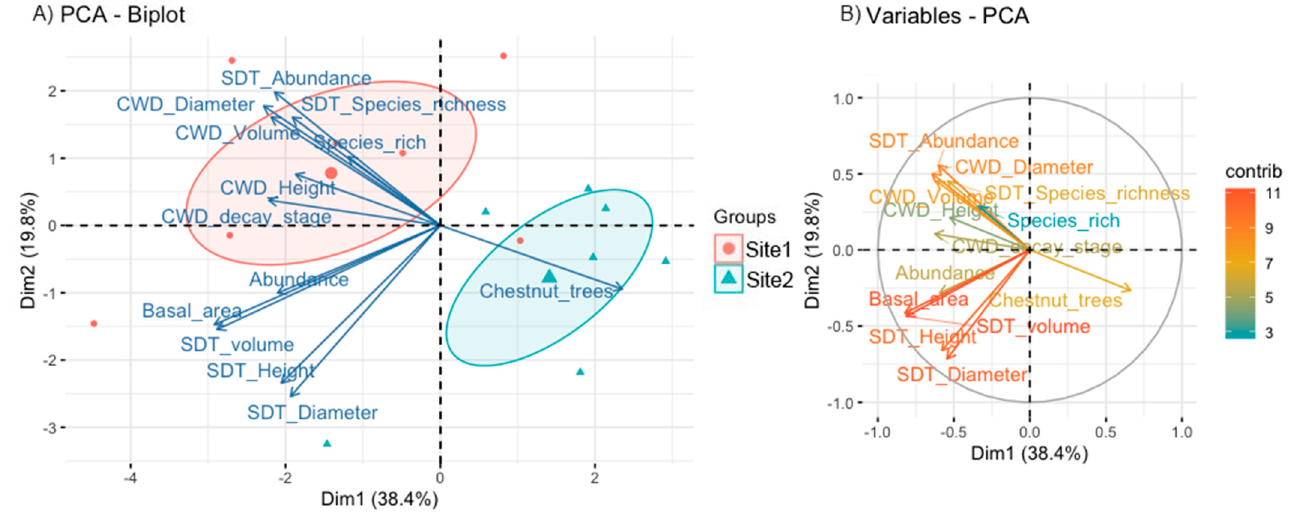
Figure 1. PCA results on forest variables: ( A ) Biplot and ( B ) contributions of each variable. ( A ) Red points (one point for each trap) represent Site 1; while blue triangles (one triangle per each trap) Site 2. The large red point and the large blue triangle represent centroids of the all traps per site. ( B ) All variables are presented with their distribution and contribution in the cartesian axes. Table 2. Thirteen environmental variables collected in the field to characterize the plot area surrounding each window trap. CWD stands for Coarse Woody Debris, while SDT stands for Standing Dead Trees. 0.01 * p ‐ value ≤ 0.05.